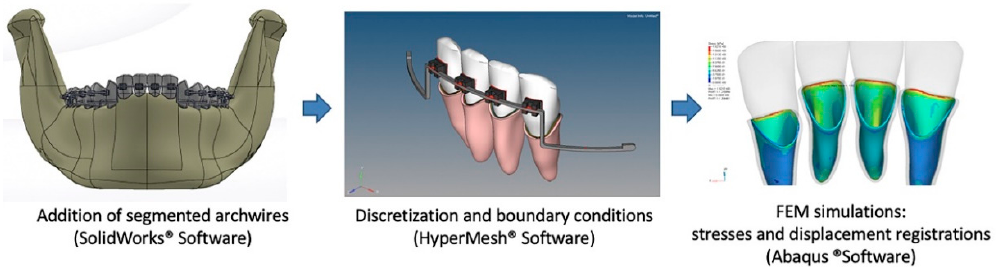
Figure 2. Sequence for segmented arch technique graphic representation and finite element model (FEM) discretization and simulation.